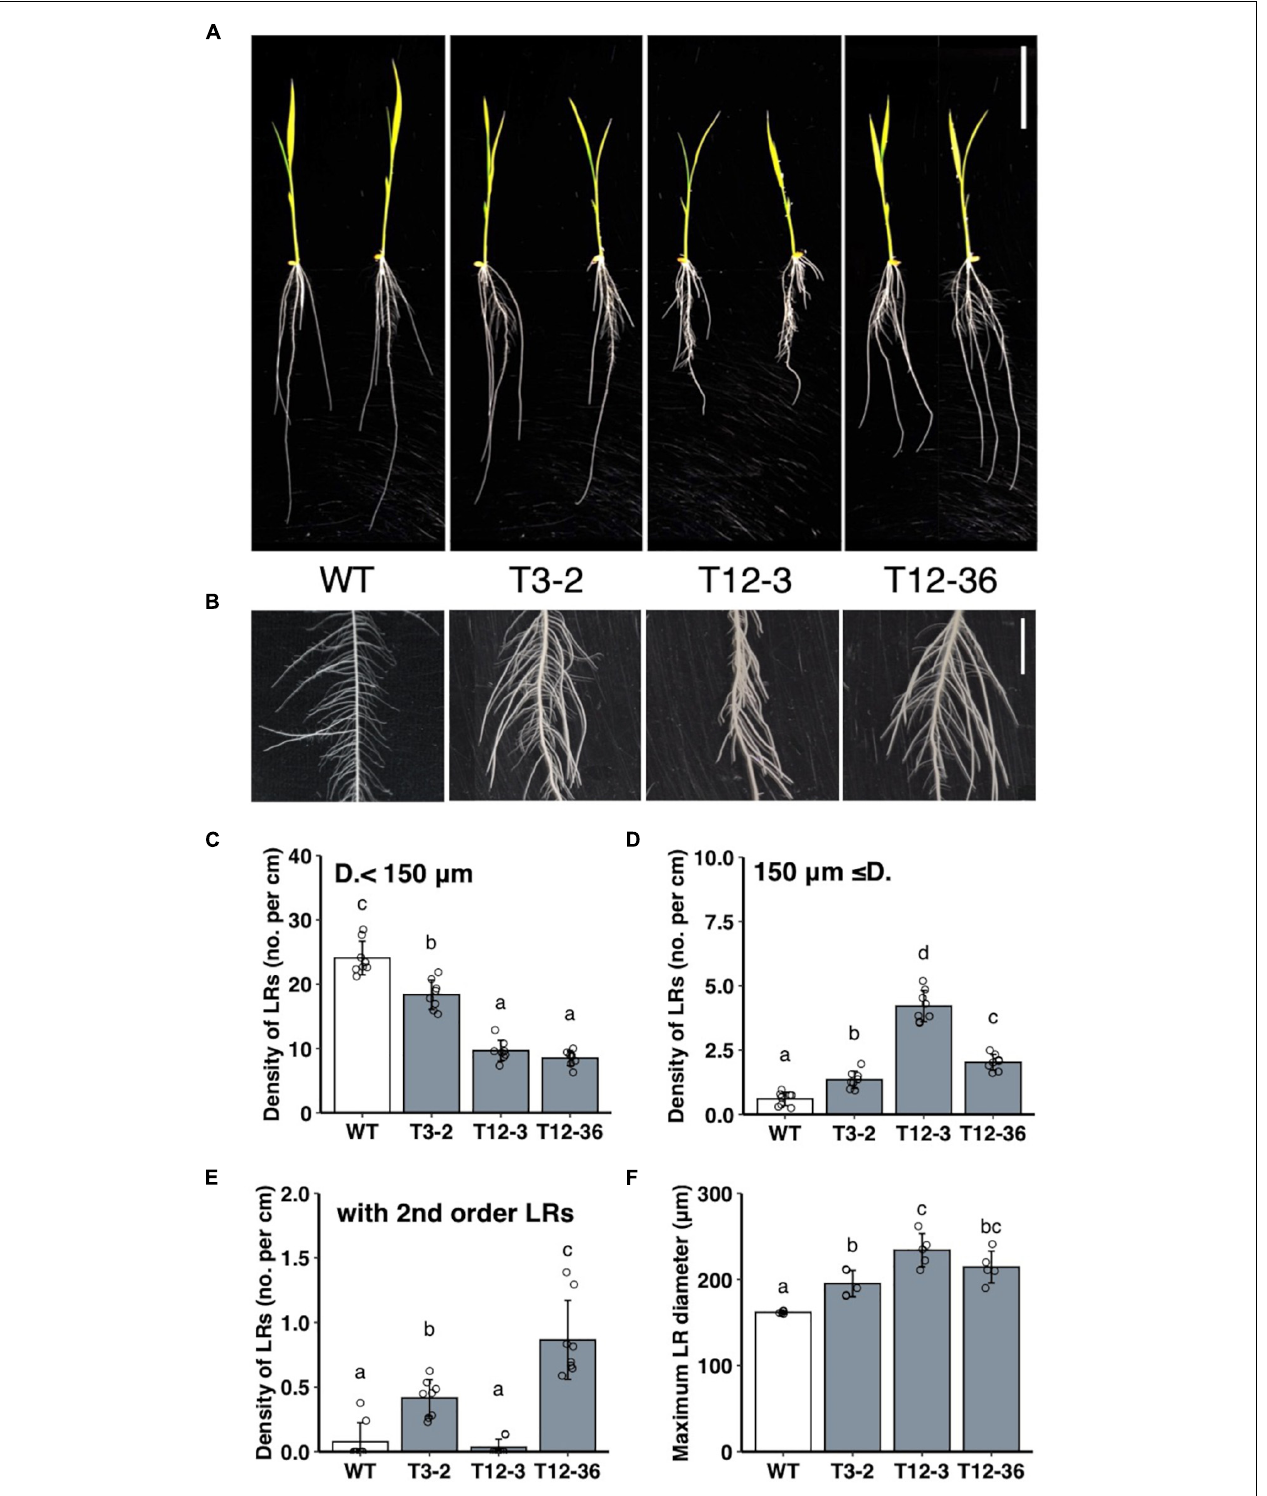
FIGURE 1 | Analysis of lateral root (LR) formation on seminal roots (SRs) in 10-day-old seedlings of the wild-type (WT) rice and mutants (T3-2, T12-3, and T12-36). (A) Shoot and root phenotypes. Two representative plantlets are shown. Scale bar = 5 cm. (B) LR phenotypes on SRs. Scale bar = 1 cm. (C,D) Density of LRs in two different diameter classes. D., LR diameter. (E) Density of first-order LRs forming second-order LRs. (F) Maximum LR diameter. Values represent mean ± SD [ n = 8 (C–E) and 5 (F) independent biological replicates]. Different letters indicate significant differences among genotypes ( P < 0.05).